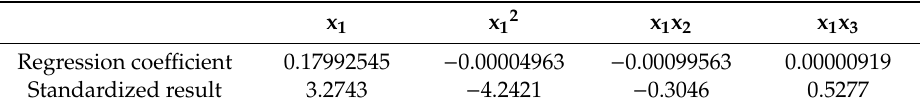
Table 6. Standardization of Regression Analysis Coe ffi